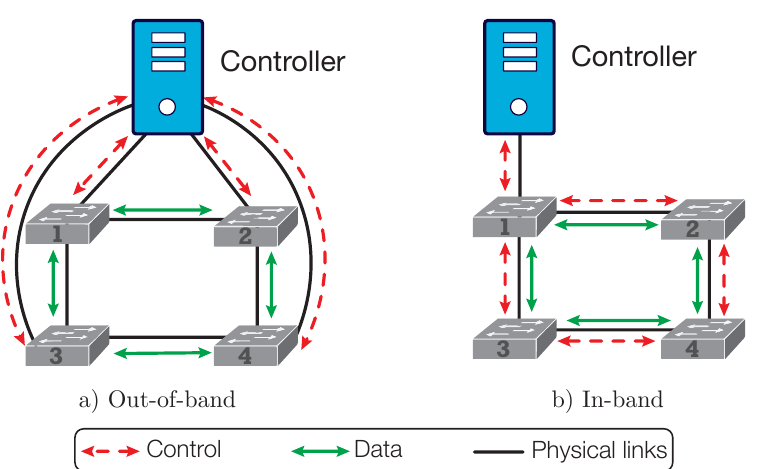
Figure 1. SDN out-of-band and in-band control networks.